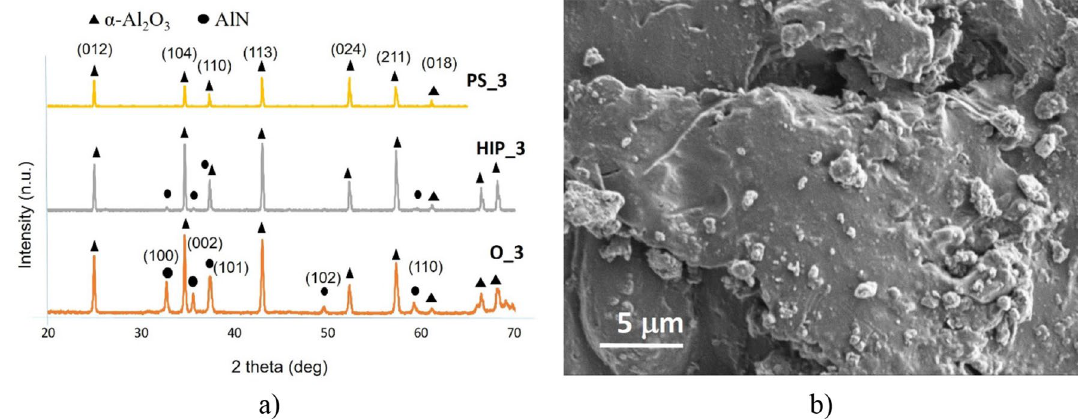
Figure 5. Investigation of oxidized AlN at 3 h. ( a ) XRD plots of oxidized AlN powder (O_3), HIP sintered (HIP_3) and sintered at H